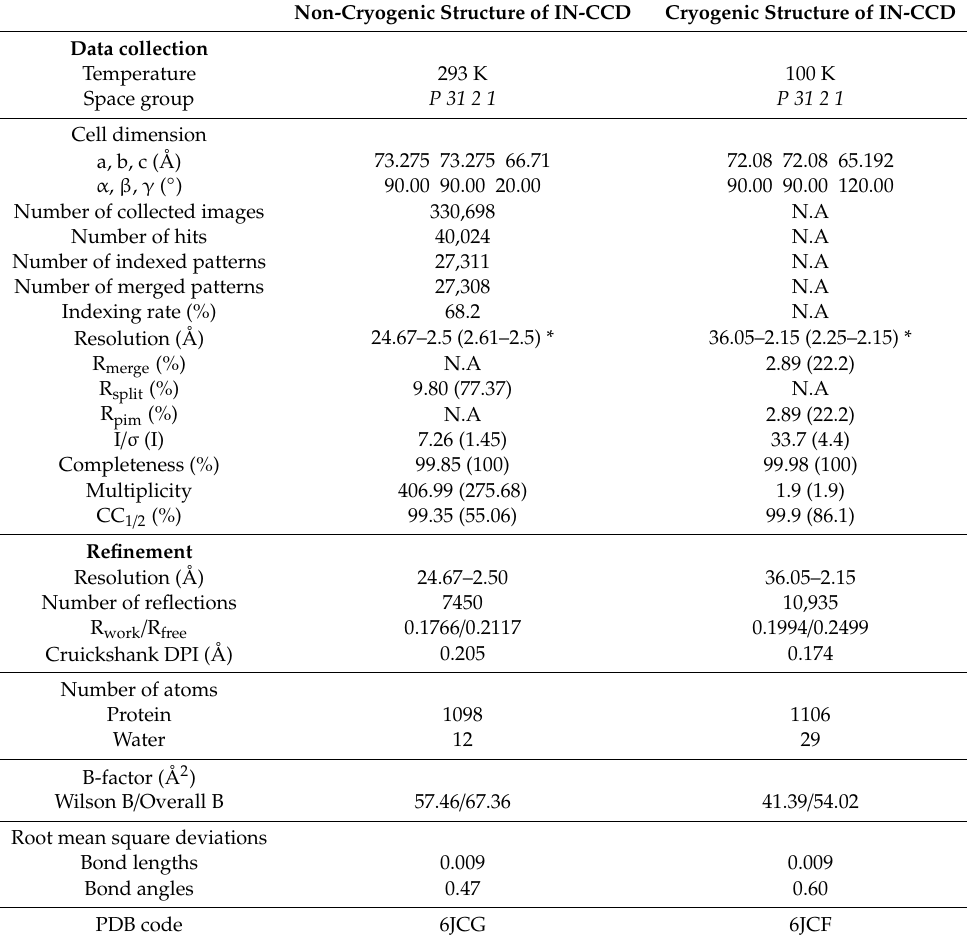
Table 1. Data collection and refinement